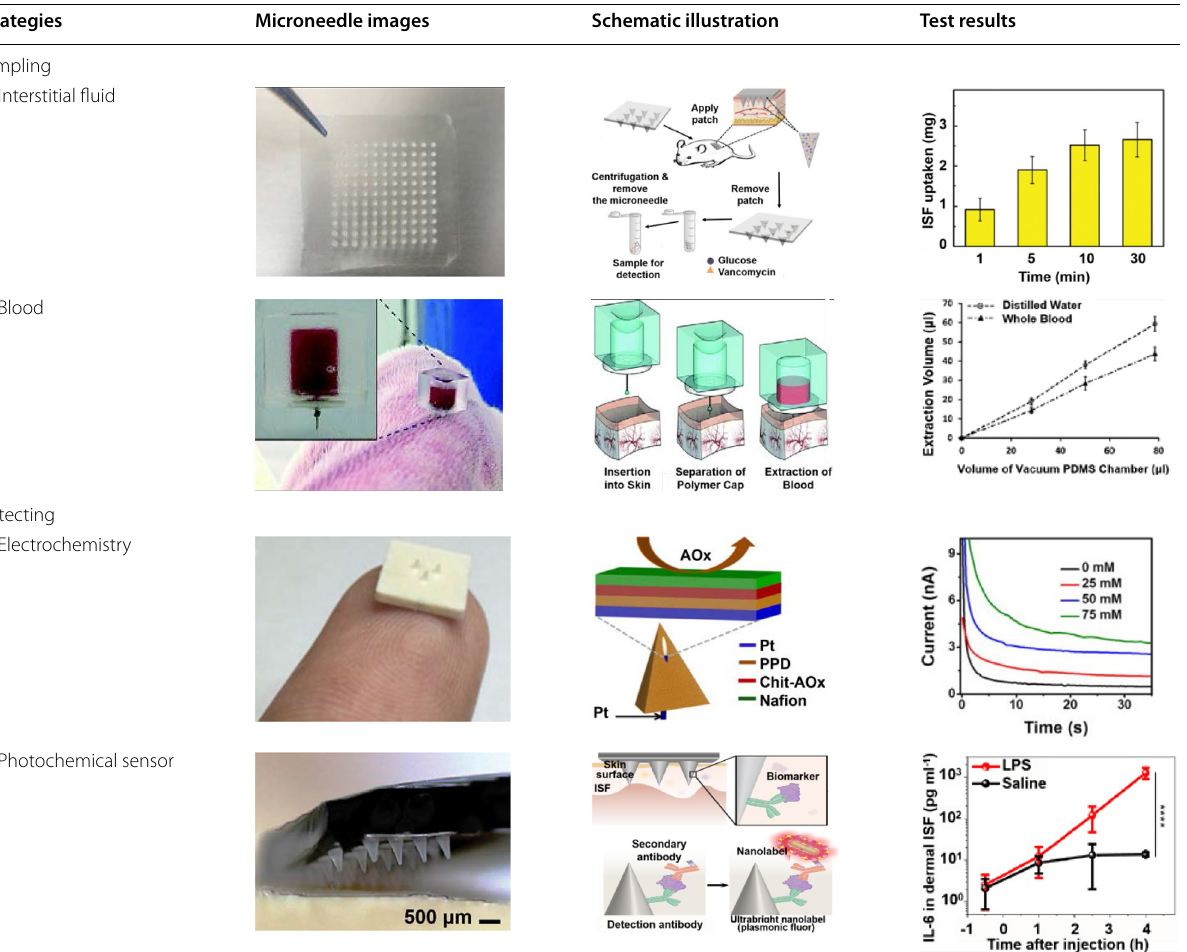
Table 8 Disease diagnosis of microneedles Strategies Microneedle